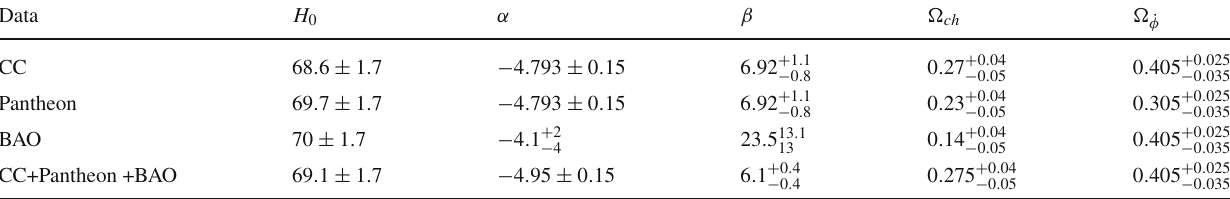
Table 3 Mean values of free parameters of chameleon model with 1 σ error bar for different data Data